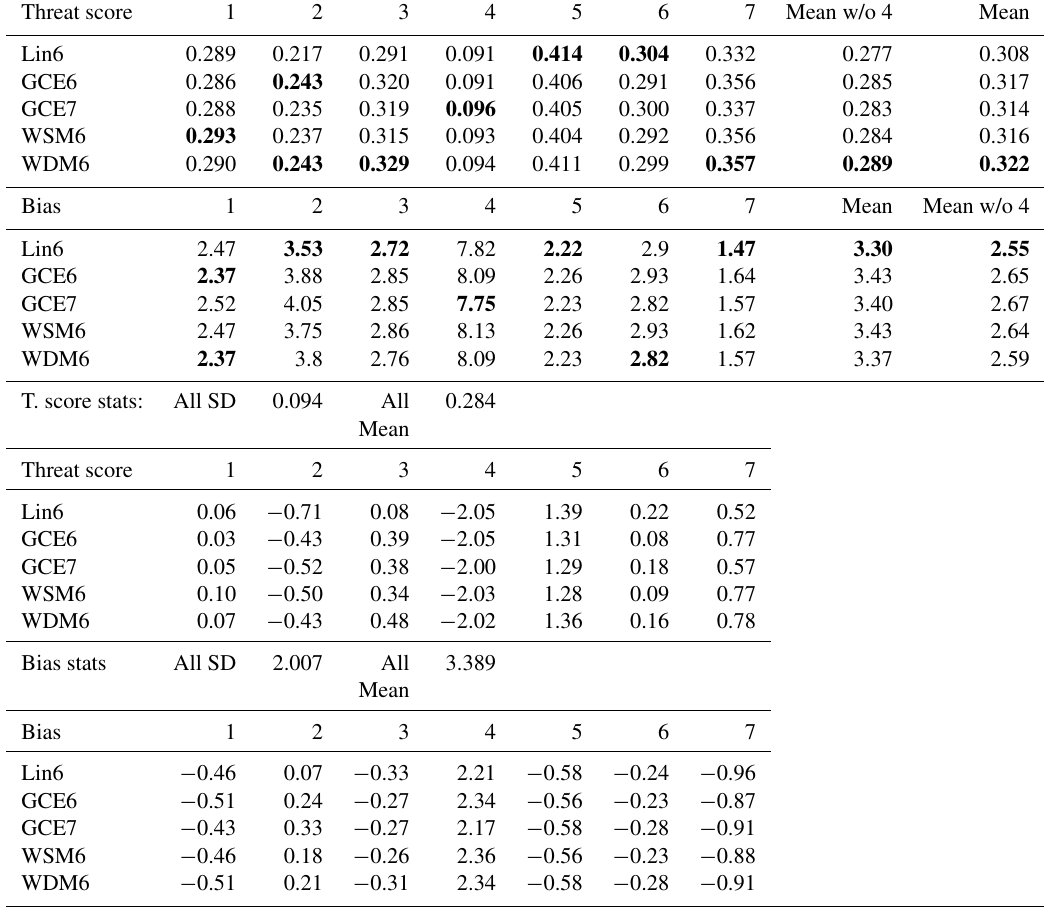
Table 3. Domain 3, Stage IV-relative, accumulated precipitation threat scores and biases assuming a threshold value of 10mm (25th percentile of 24h accumulated precipitation). Bolded values denote the model simulation with the threat score closest to 1 (perfect forecast) or a bias values closest to 1 (number of forecasted cells matches observations). The lower two panels indicate the number of standards deviations (SD) each threat score and bias value deviates from the composite (all models + all cases)